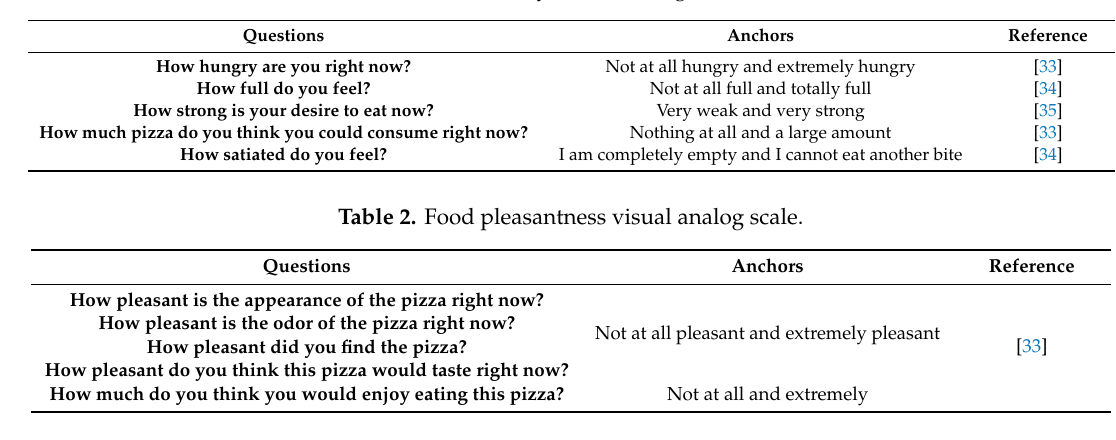
Table 1. Satiety visual analog scale.